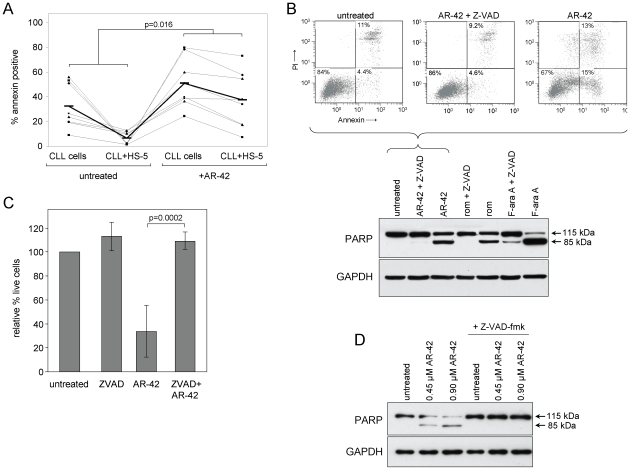
AR-42 efficacy is independent of stromal survival factors but involves caspase activation.(A) CLL patient cells (n = 8) were incubated 16 hr with or without AR-42 (0.90 µM), then washed and cultured in the absence or presence of HS-5 stromal cells for a total of 48 hr. CLL cells were collected and analyzed by flow cytometry. Data for each patient are shown individually (light dotted lines) as absolute percent annexin-positive cells. Averages for each group are shown as a dark bar, connected by a solid line. The difference in HS-5 protection of CLL cells between untreated and AR-42 treated was significant (p = 0.016). (B) JeKo-1 cells (n = 3) were incubated 24 hr with or without AR-42 (0.90 µM), romidepsin (rom; 0.04 µM), F-ara A (5.0 µM) and Z-VAD-fmk (100 µM). Cells were analyzed by annexin/PI flow cytometry (top) or by immunoblot for PARP (bottom). Results with 697 cells were similar. (C) CLL cells (n = 5) were incubated with or without AR-42 (0.90 µM) and Z-VAD-fmk (100 µM). Cells were analyzed by flow cytometry at 48 hr and percent live cells (annexin and PI negative) were calculated relative to time-matched untreated samples. Bars represent +/− standard deviation. In AR-42 treated cells, increase in live cells with Z-VAD-fmk was significant (p = 0.0002). (D) Extracts from CLL cells incubated 24 hr with or without AR-42 and Z-VAD-fmk were immunoblotted for PARP. Result is representative of seven CLL samples.